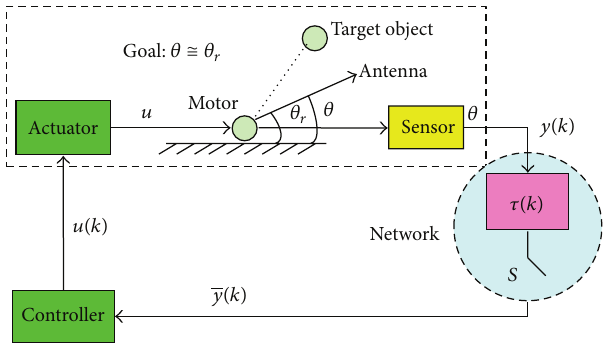
Figure 2: The angular positioning system.